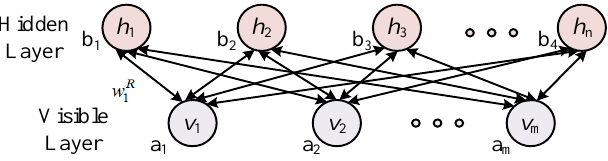
Figure 1. Structure of the RBM.